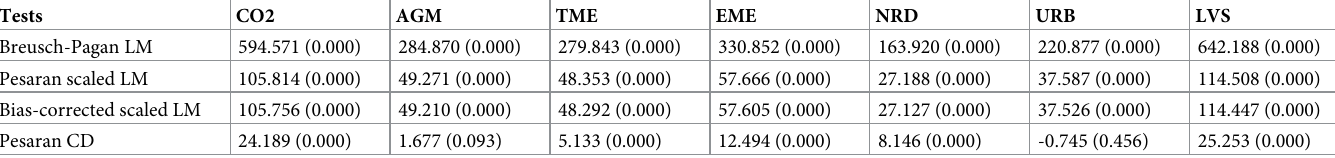
Table 4. Cross-sectional dependence test